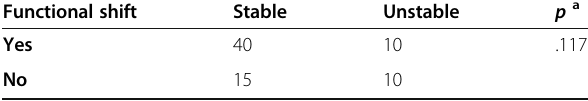
Table 3 Cross tabulation of functional shift and chi-square test Functional shift